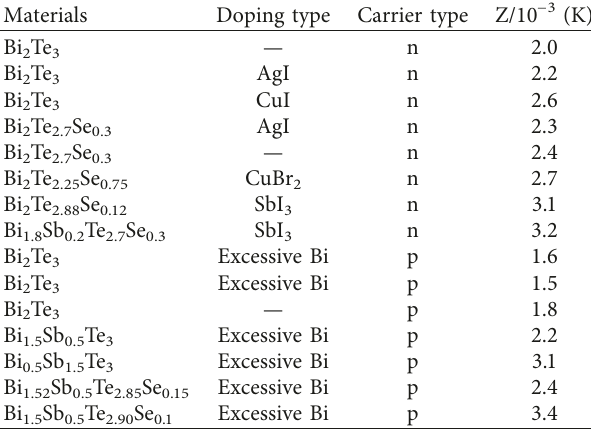
Table 4: Comparison of different preparation methods of Bi-Te- based material.